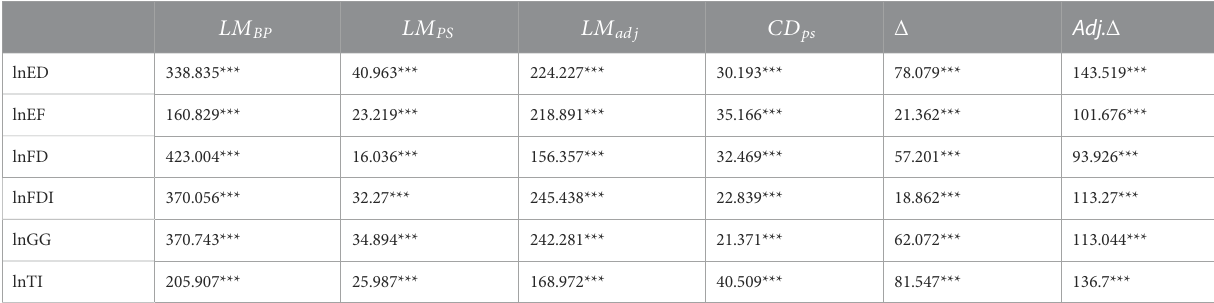
TABLE 7 Results of CST and SHT.